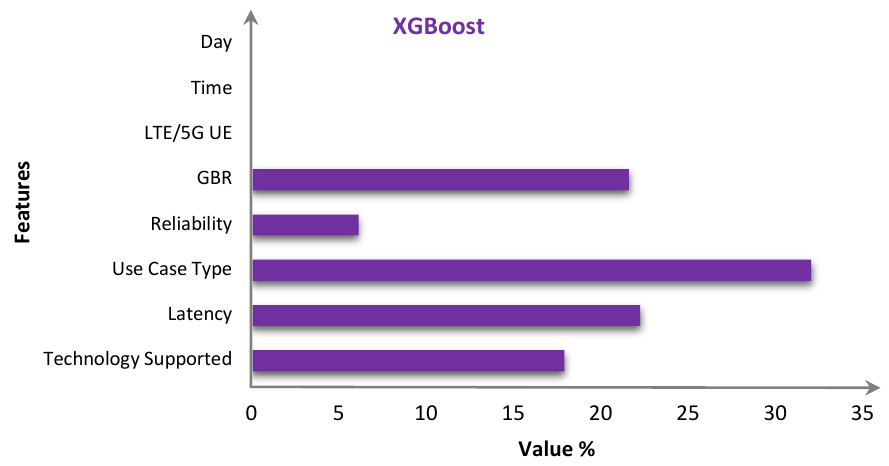
Figure 6. Feature Importance of XGBoost Algorithm.